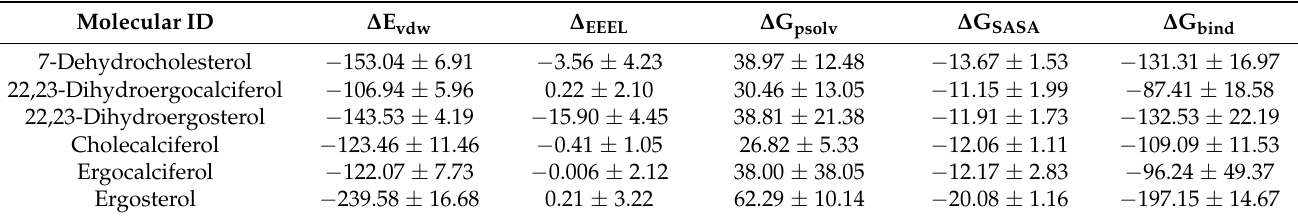
Table 7. MM/PBSA binding free energy (in kJ/mol) for vitamin D isoforms binding to SARS-CoV-2 papain-like protease.